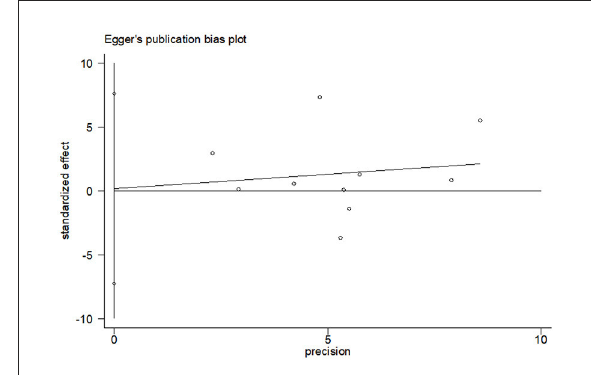
FIGURE4 Sensitivity analysis of CQOL-C subgroup.